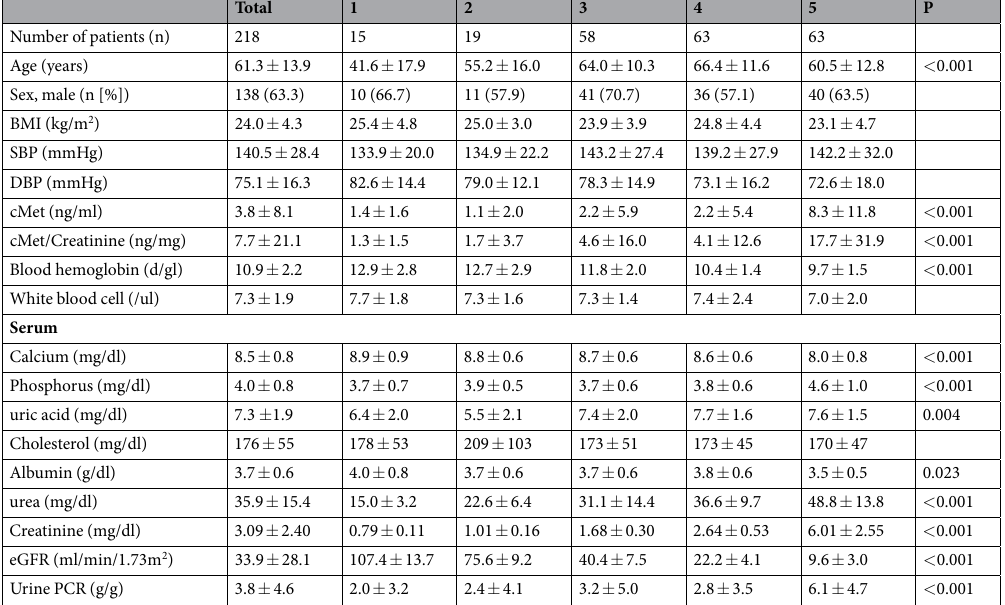
Table 1. Baseline characteristics of CKD patients. Categorical variables were presented as n (%), and continuous variables were shown as mean ± standard deviations. BMI, body mass index; SBP, systolic